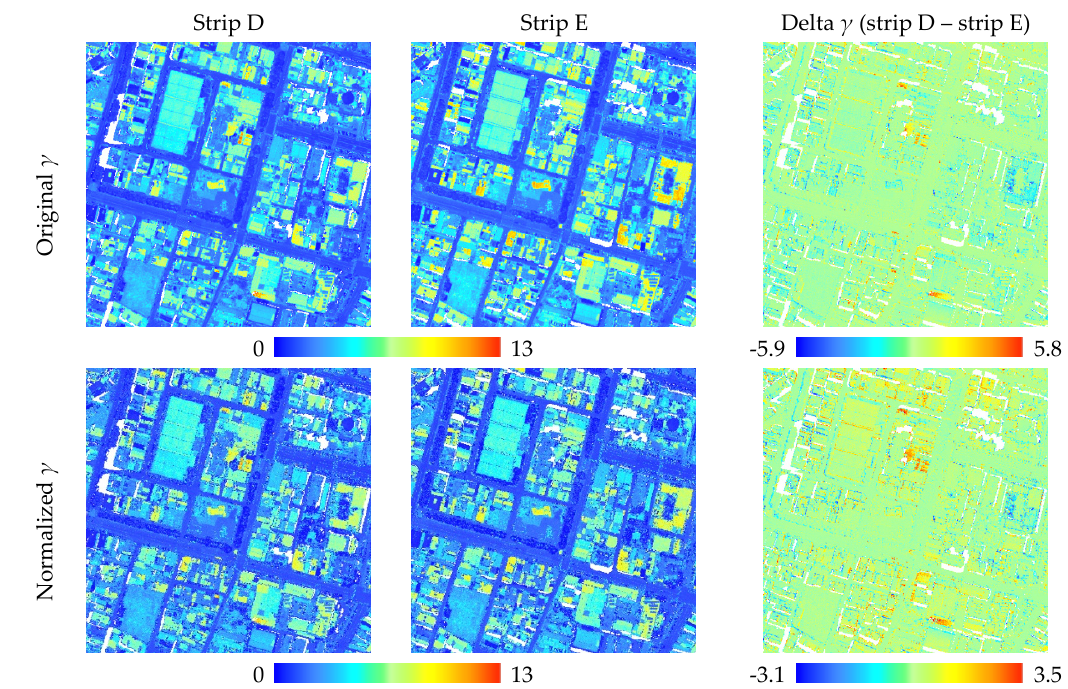
Figure 11. Delta backscattering coefficient in overlapped area.